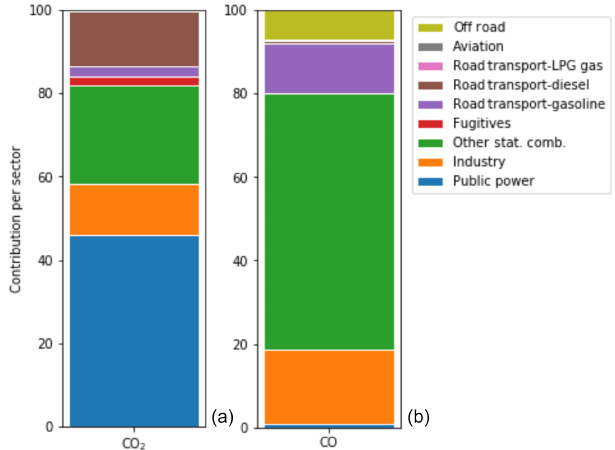
Figure 8. Contribution of source sectors to the total uncertainty in CO 2 (a) and CO emissions (b) , summing to